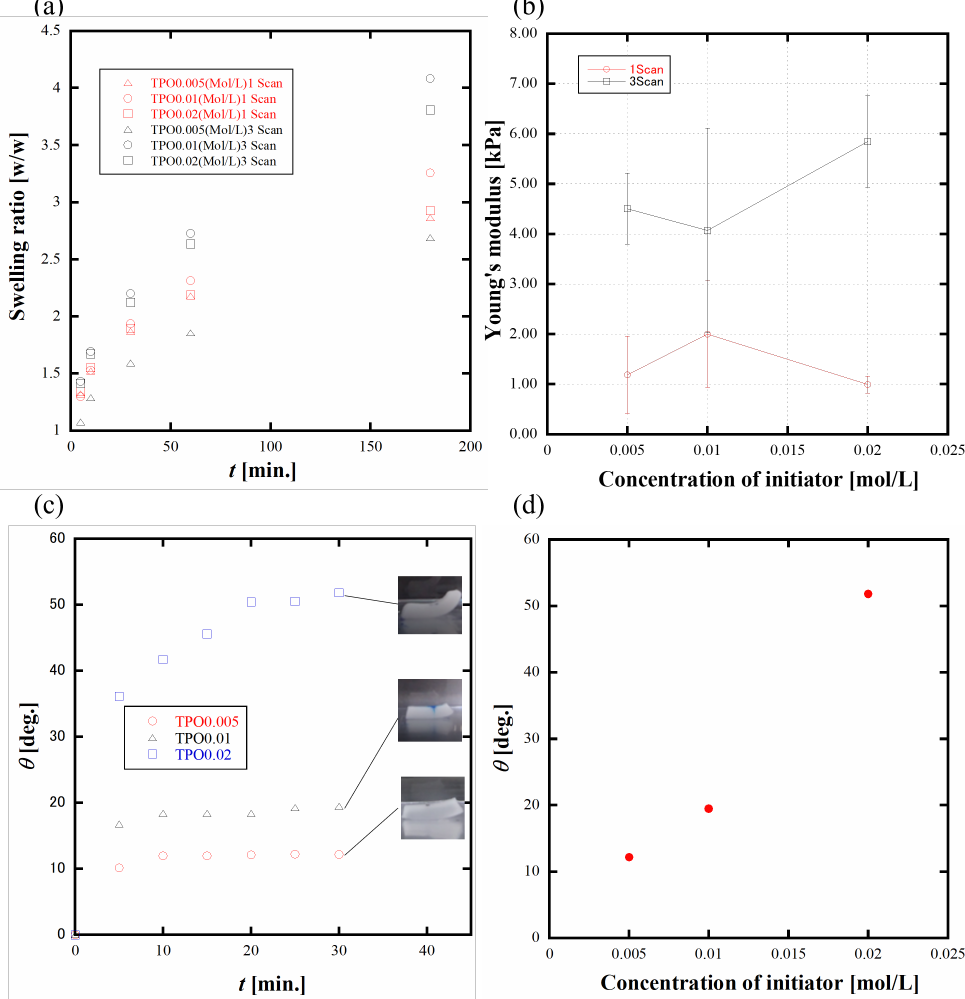
Figure 4. ( a ) The swelling ratio measurement as a function of time, in the various concentrations of the initiator TPO and in the one or three scanning numbers of UV irradiation in 3D printing. ( b ) The Young’s modulus measurement as a function of the concentration of the initiator TPO in the one or three scanning numbers of UV irradiation in 3D printing. ( c ) The bending angle with the various concentrations of the initiator TPO. The inset photographs indicate the final states of deformation. ( d ) The bending angle vs. the concentration of the initiator